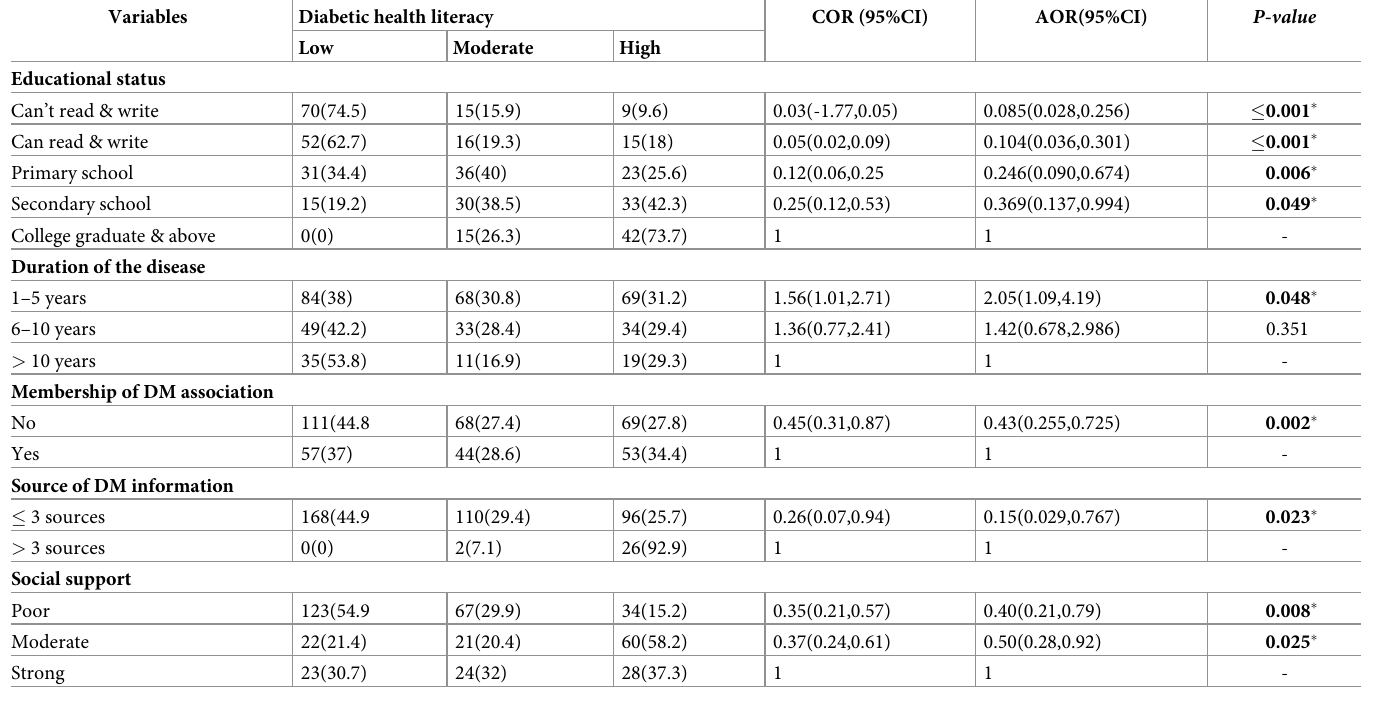
Table 5. Ordinary logistic regression analysis of factors associated with diabetic health literacy of respondents.